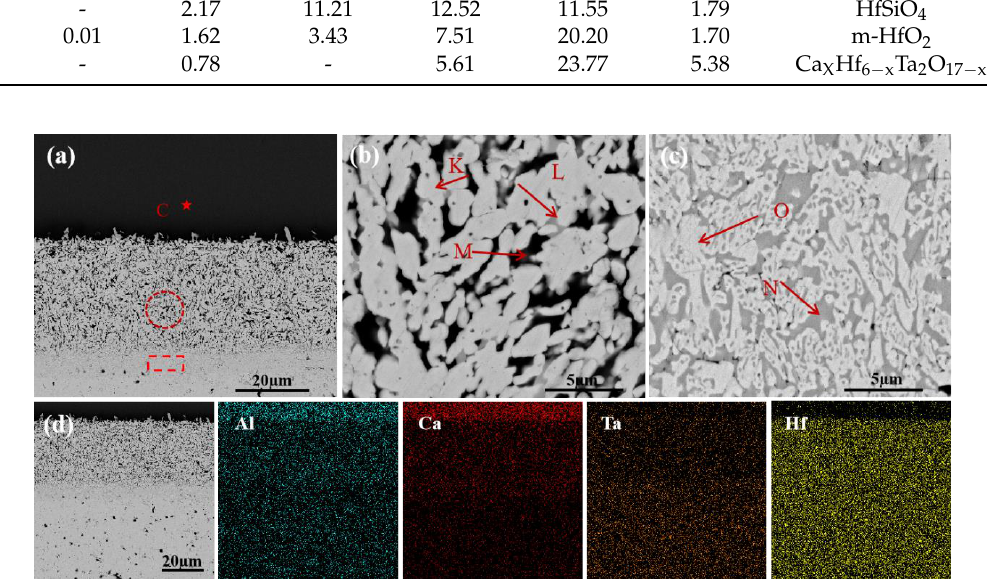
Figure 11. ( a ) A cross-sectional BSE image of Hf 6 Ta 2 O 17 ceramic after CMAS corrosion at 1300 °C for 16 h; ( b ) the high magnification BSE image corresponding to the dashed rectangle in ( a ); ( c ) the high magnification BSE image corresponding to the dashed circle in ( a ); ( d ) cross-sectional EDS mapping results of Hf 6 Ta 2 O 17 ceramic.